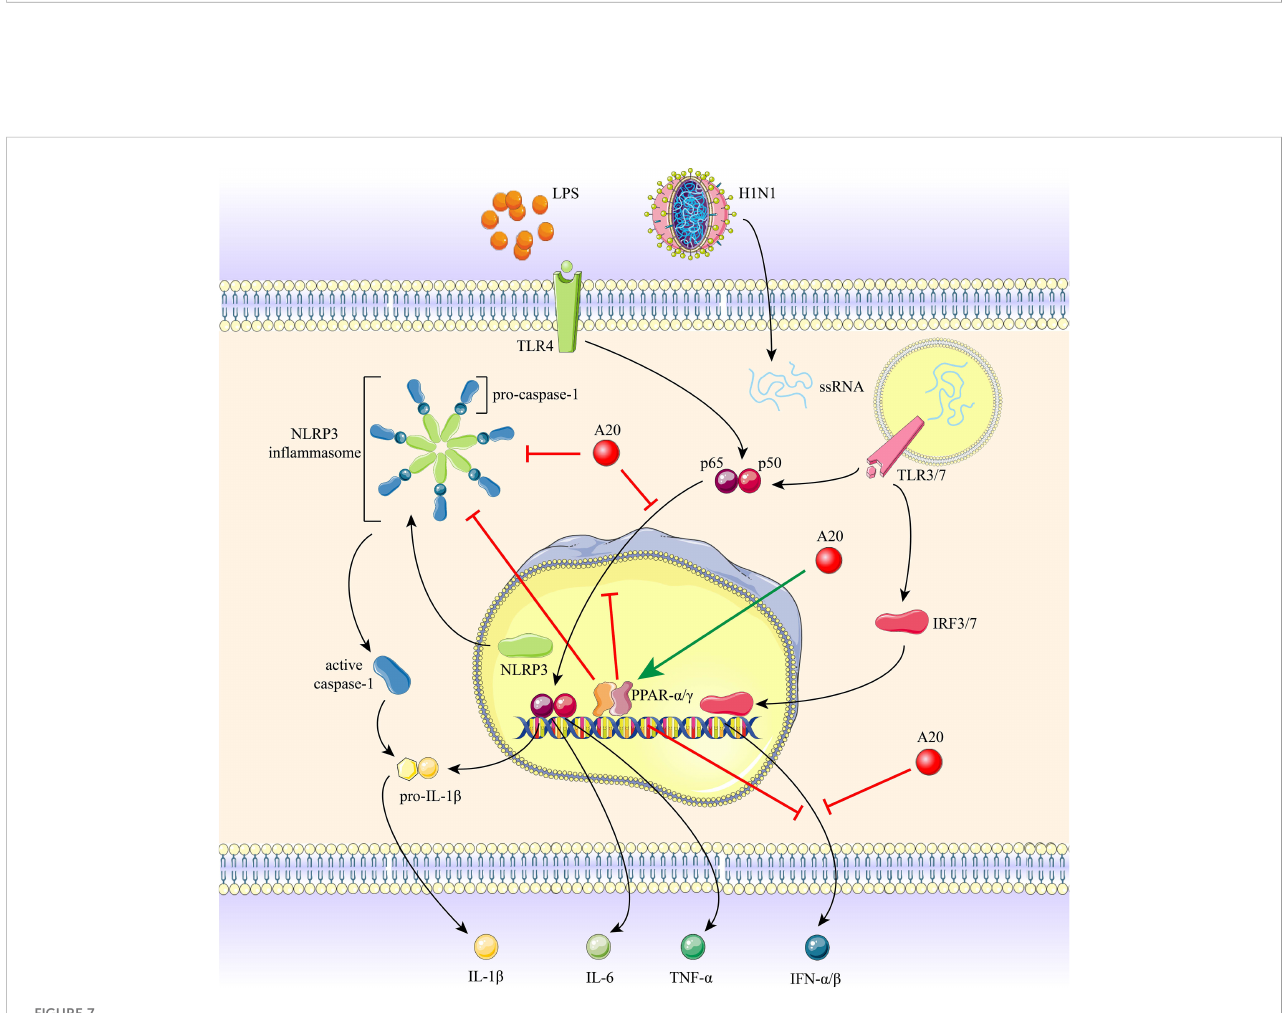
FIGURE 7 The role of A20 and PPAR- a and - g in H1N1 infection and LPS stimulation induced in fl ammation. Recognition of H1N1 ssRNA or LPS by TLRs initiates the activation of NF- k B and NLRP3 in fl ammasome, promoting the production of downstream pro-in fl ammatory cytokines. Chronic low-dose LPS environment induced a marked increase in A20 expression, resulting in the restriction of NLRP3 in fl ammasome, caspase-1 cleavage, nuclear translocation of p65 subunit and IFNs expression. A20 increases PPAR- a and - g expression, and PPAR- a and - g also inhibit the above-mentioned in fl ammatory